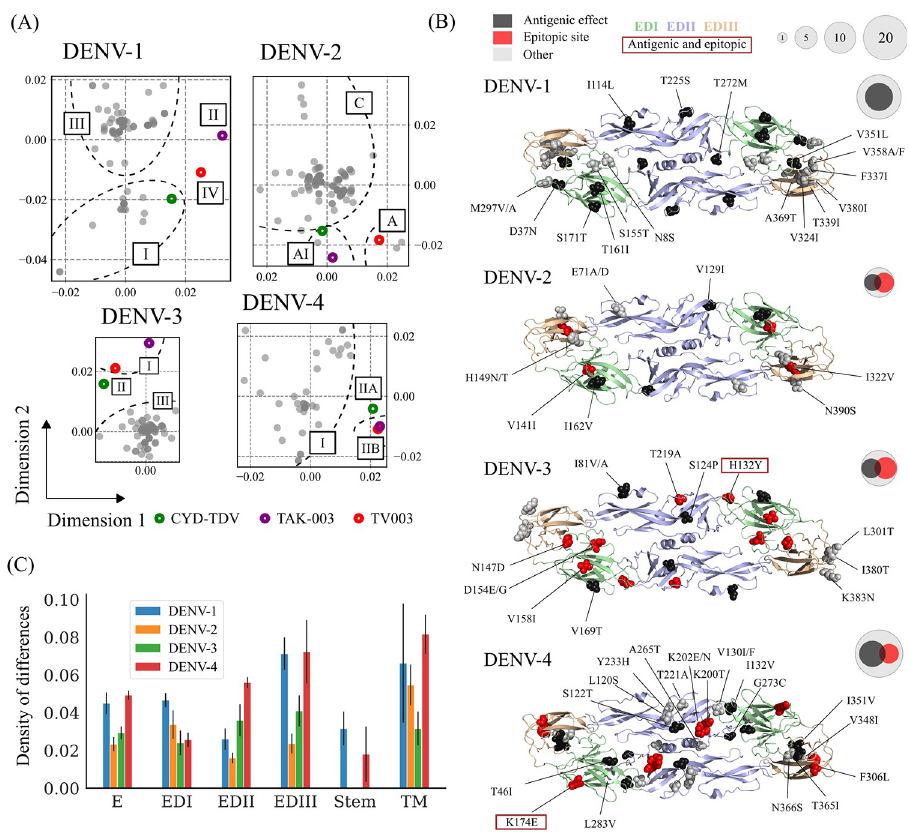
Fig 5. Comparison of Indian envelope protein sequences with vaccine strains. (A) Relative amino acid differences between Indian envelope sequences (post-2000) and vaccine strains (CYD-TDV, TV003 and TAK-003). The multidimensional scaling was used to reduce the dimensions of the data using the hamming distance matrix. Genotype cluster boundaries are indicated with dotted lines for visual clarity. Indian sequences are shown in grey; vaccine strains are shown with empty circles. (B) Amino acid differences at a frequency > 10% with respect to the CYD-TDV vaccine are shown on the envelope protein dimer structure. Different positions in the known epitopic regions are shown in red. Variable residues within the predicted antigenic effect positions are shown in black. Residues present in epitopic regions with predicted antigenic effects are highlighted with a box. Venn diagram shows the total number of differences in the full E protein (including the stem and transmembrane region), epitopic sites and antigenic sites. The circle size represents the number of differences category-wise. (C) The density of differences (number of differences/ length of the domain) is shown for different domains of the envelope protein (envelope domains EDI-III, stem and transmembrane (TM) region). The error bars represent the standard deviation across the three vaccine strains.